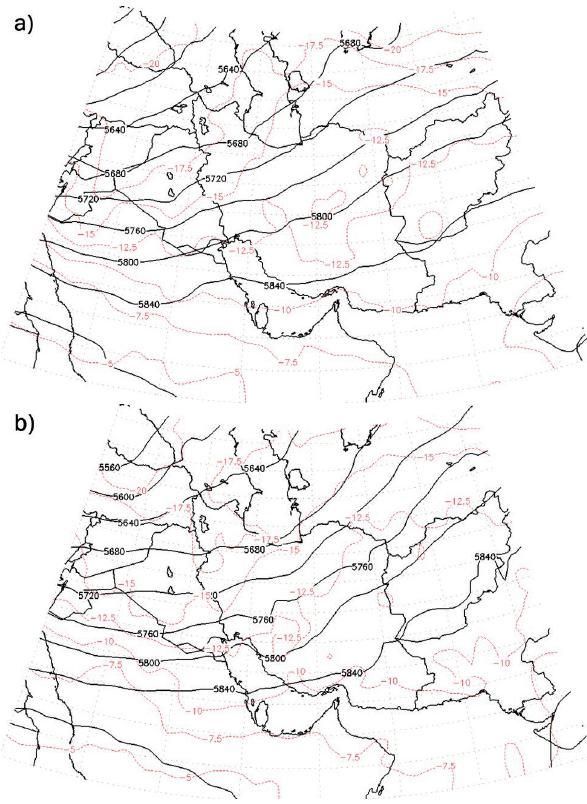
Fig. 6. (a) 500hPa chart include contours with 40m and isotherms with 2.5 ◦ C intervals, respectively, on 30 April 2009 at 00:00UTC. (b) 500hPa chart include contours with 40m and isotherms with 2.5 ◦ C intervals, respectively, on 30 April 2009 at 12:00UTC.